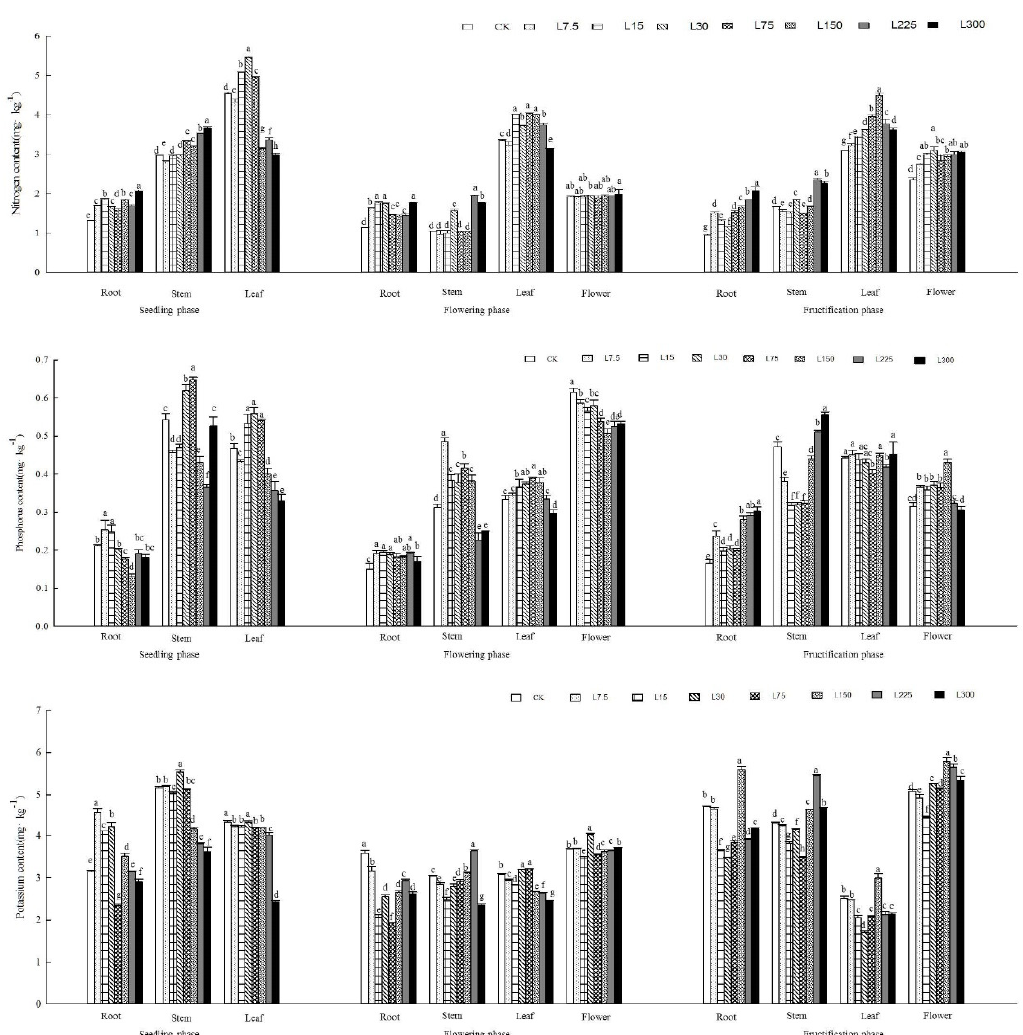
Figure 5. Effect of Cd stress on nutrient distribution in Tagetes patula . The leaf for the measurement of N, P and K was sampled on days 30 (seedling phase), 79 (flowering phase) and 122 (fructification phase) after transplantation. Each bar denotes the mean of 3 replicates, with standard error based on means (MSE). Different letters indicate significant differences among Cd concentrations within the same growth stage and organ compared by Fisher’s least significant differences (LSD) test at p ≤